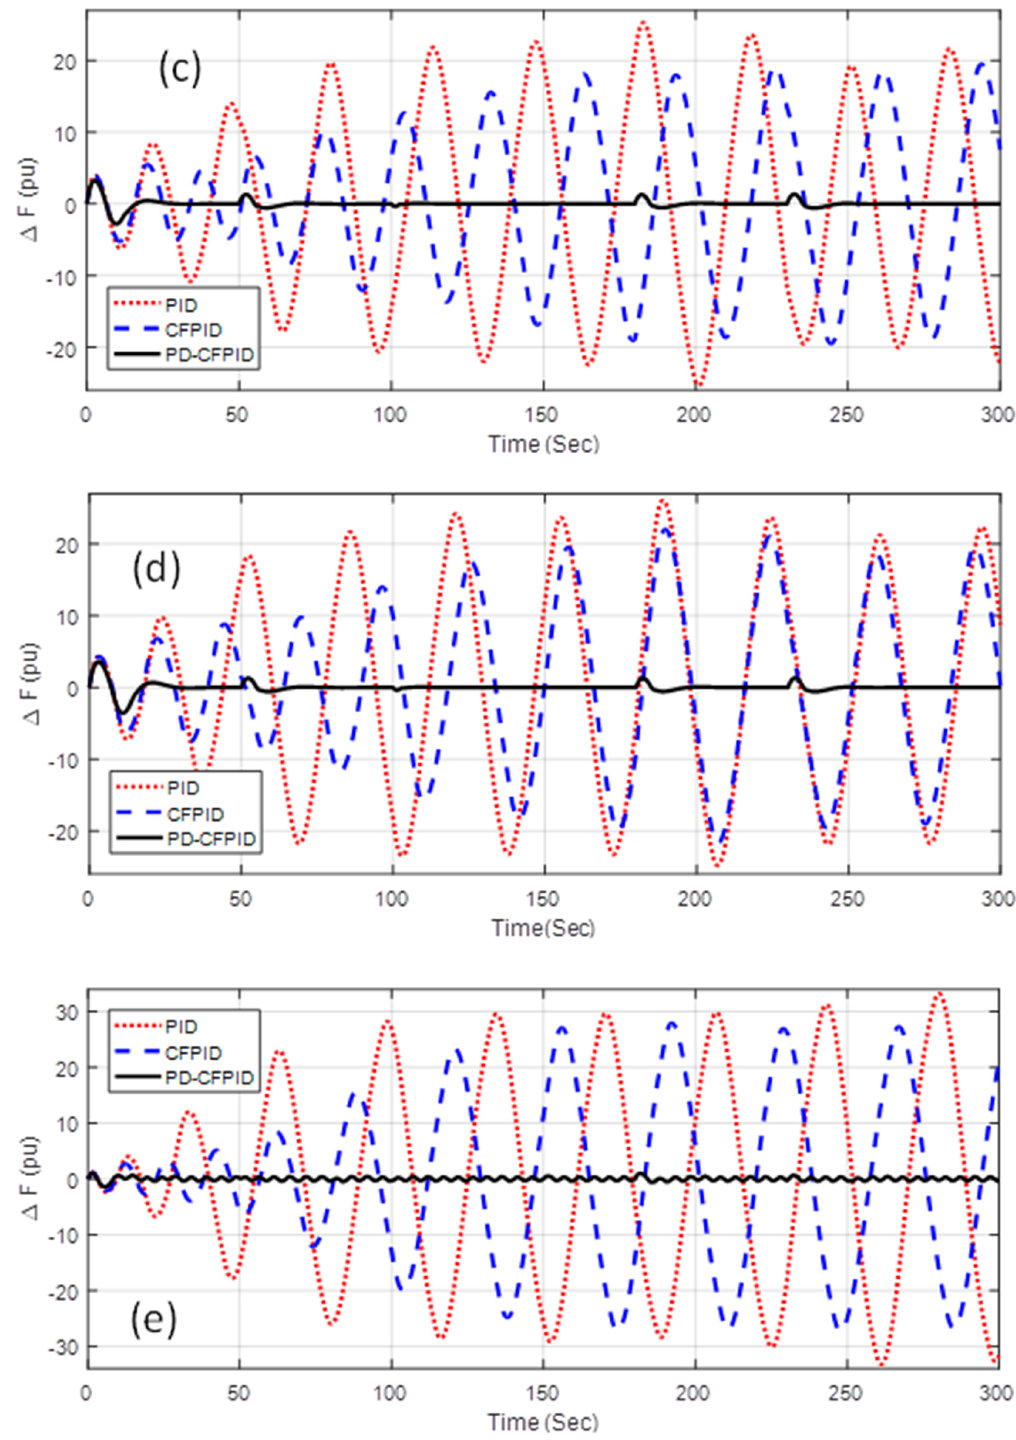
Figure 10. System response under uncertain cases. ( a ) System response for scenario A. ( b ) System response for scenario B. ( c ) System response for scenario C. ( d ) System response for scenario D. ( e ) System response for scenario